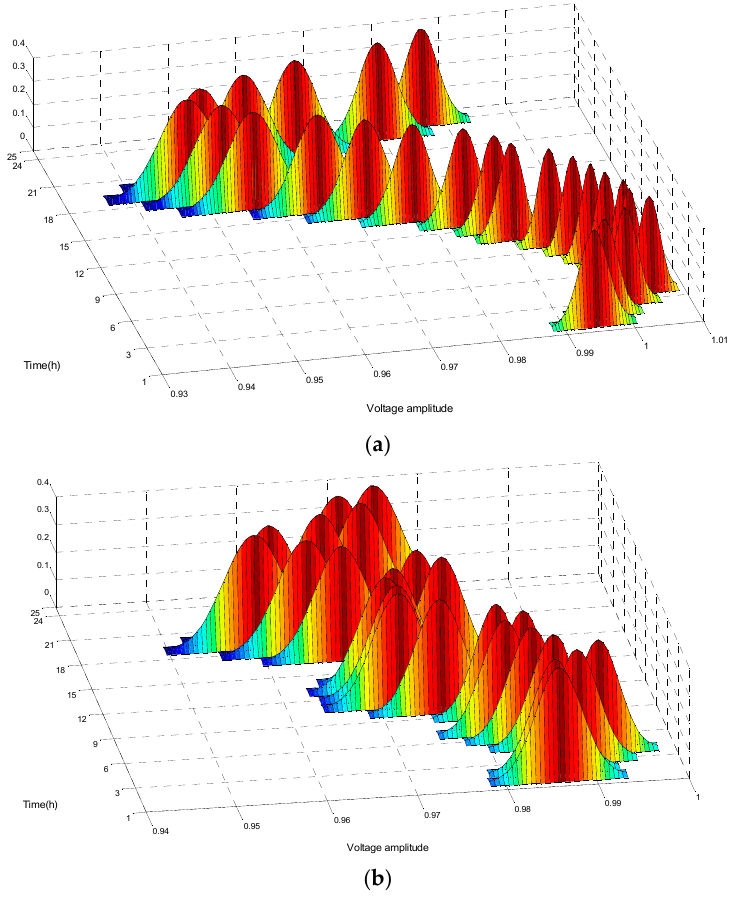
Figure 14. The voltage probabilistic distribution of bus 26. ( a ) Case 2; ( b ) Case 3.